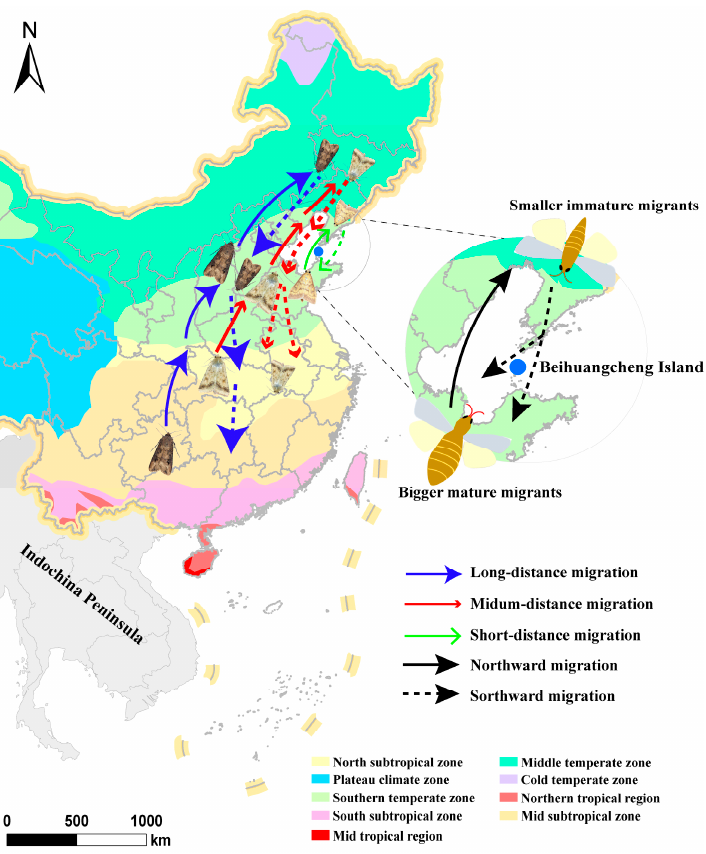
Figure 1. Schematic diagram of migration patterns and physiological characteristics of insects across Bohai Sea.